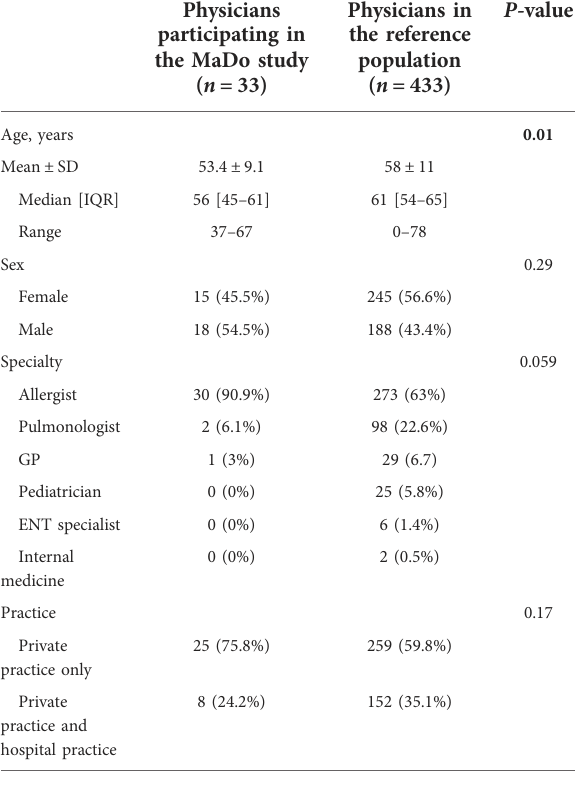
TABLE 1 Characteristics of the participating physicians and a reference population of allergists and other physicians with expertise in treating allergies in France (listed in the OneKey® database from IQVIA, La Défense, France).